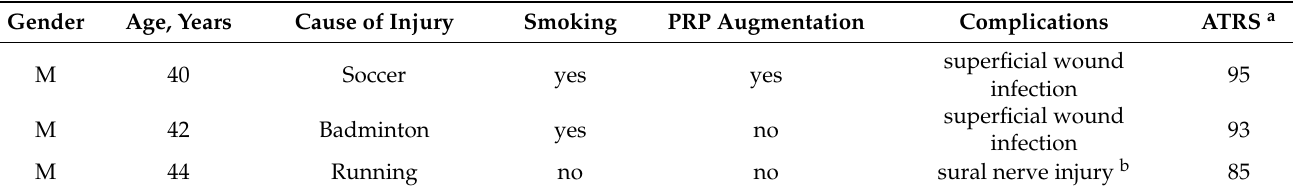
Table 4. Characteristics of patients developing